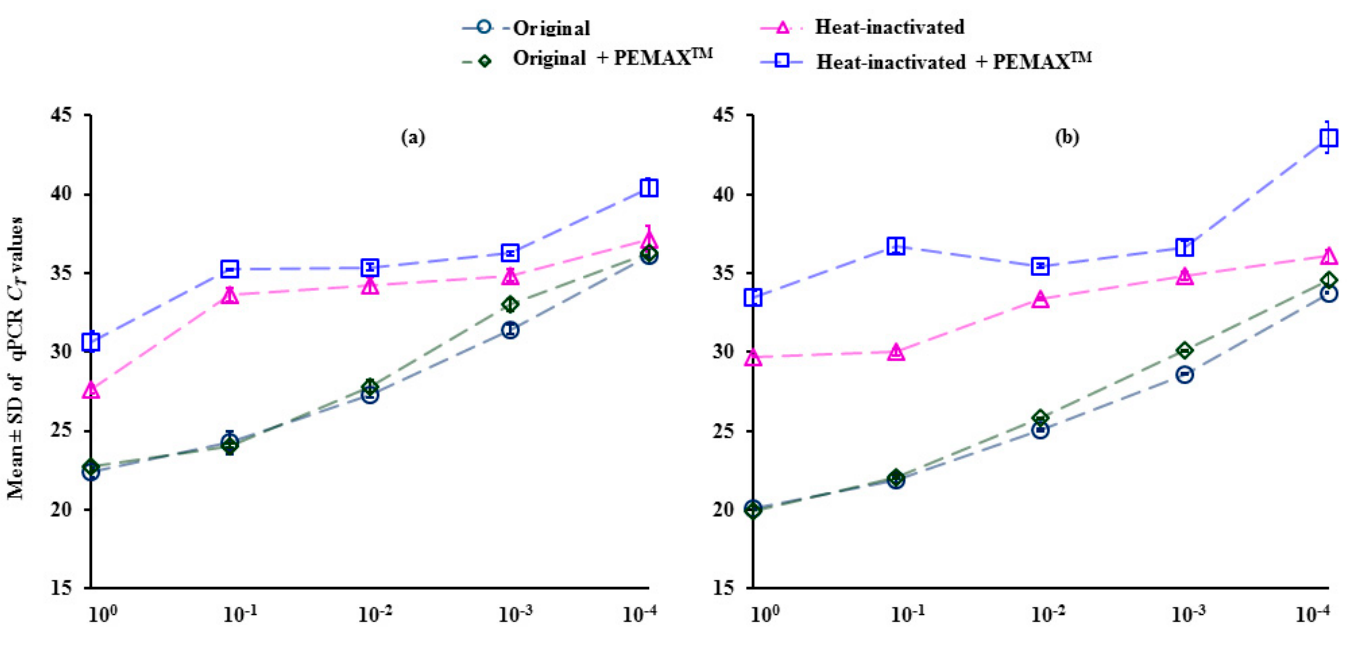
Figure 4. qPCR C T values (mean and standard deviation) of serially-diluted original (non-heat-inactivated) and heat-inactivated ( a ) norovirus GI.3 and ( b ) norovirus GII.4 with and without PEMAX TM treatment.